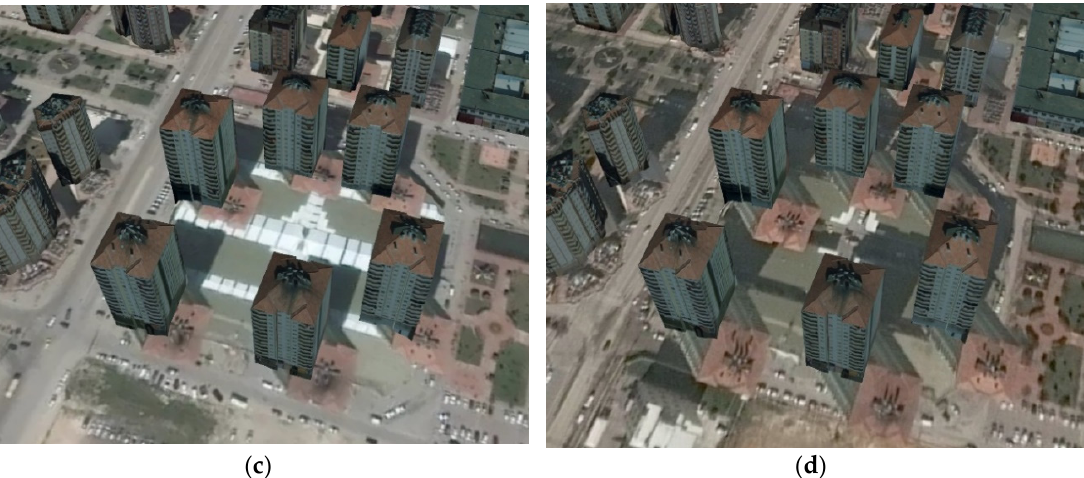
Figure 16. Three-dimensional buildings visualized on ( a ) true orthophoto basemaps, ( b ) Bing Maps, ( c ) Mapbox Satellite, and ( d ) ESRI World Imagery.